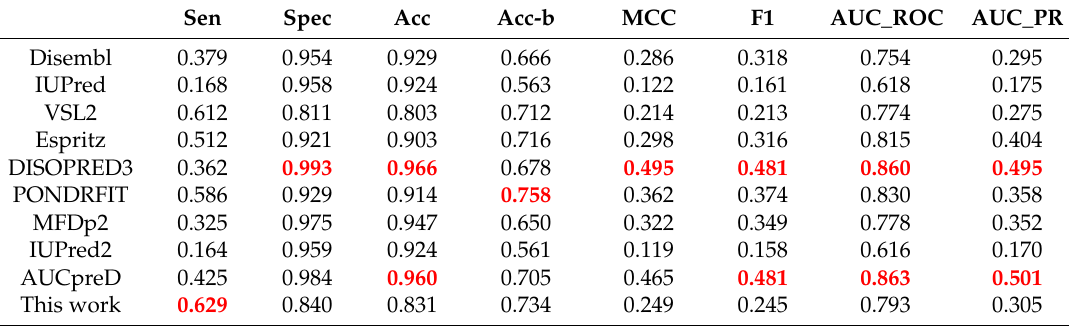
Table A1. Comparison of prediction accuracy of in the CASP10 test